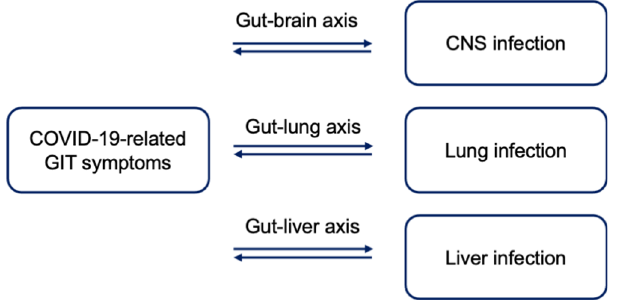
Figure 4. SARS-CoV-2 infection and perturbation of the intestinal flora homeostasis that are associated with GItractsymptoms. Theneutralaminoacid,suchastryptophan,istakenupbytheintestinalcellsthroughtheaction of an influx transporter B0AT1. To act properly, this transporter works together with ACE2. The activity of ACE2 is independent of RAS system. Once absorbed, tryptophan activates mTOR signaling pathway responsible for the regulation of intestinal antimicrobial peptides expression. During the COVID-19 course, ACE2 is invaded by SARS- CoV-2 disturbing the uptake of the amino acids by B0AT1. This condition is then followed by the inhibition of mTOR pathway resulting in the perturbances of antimicrobial peptides (i.e. defensins and RegIII γ ) secretion into the intestinal lumen. Furthermore, dysbiosis can cause several subsequent effects because it induces the production of proinflammatory cytokines, inhibits anti-inflammatory cytokines, weakens the tightness of the epithelial barrier and decreases the secretion of some beneficial metabolites from the microbiomes. Taken together, these effects result in the emergence of GIT symptoms, such as intestinal inflammation and diarrhea.